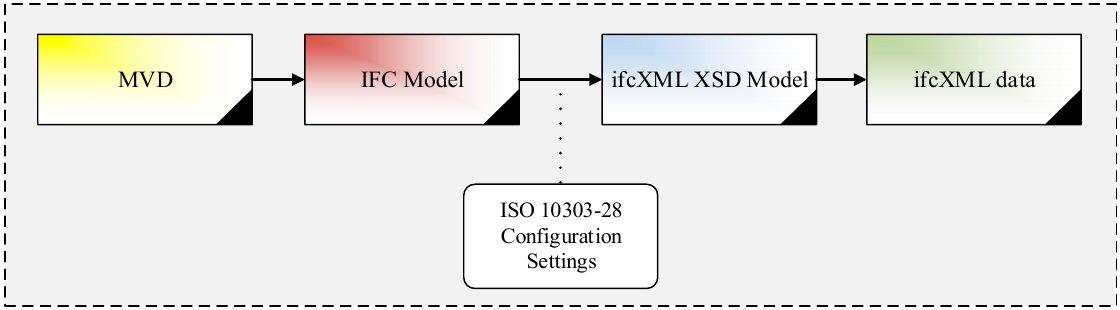
Figure 7. A part of the implementation code using C# programing language.